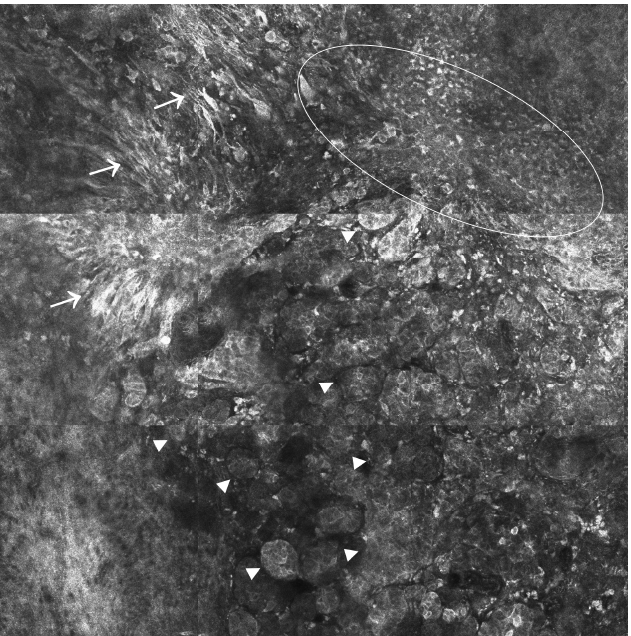
Figure 3 . Cutaneous melanoma. RCM mosaic (1500 × 1500 µm 2 ) showing severe dermo-epidermal junction disarray and pleomorphic bright cells: large dendritic atypical cells (white arrows) with the tendency to form aggregates and roundish cells of different sizes in some areas forming scattered irregular clusters (white arrowheads), in others distributed in a diffuse pattern (white circle).